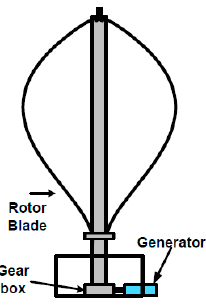
Figure 1. A typical vertical-axis turbine (the Darrius rotor).